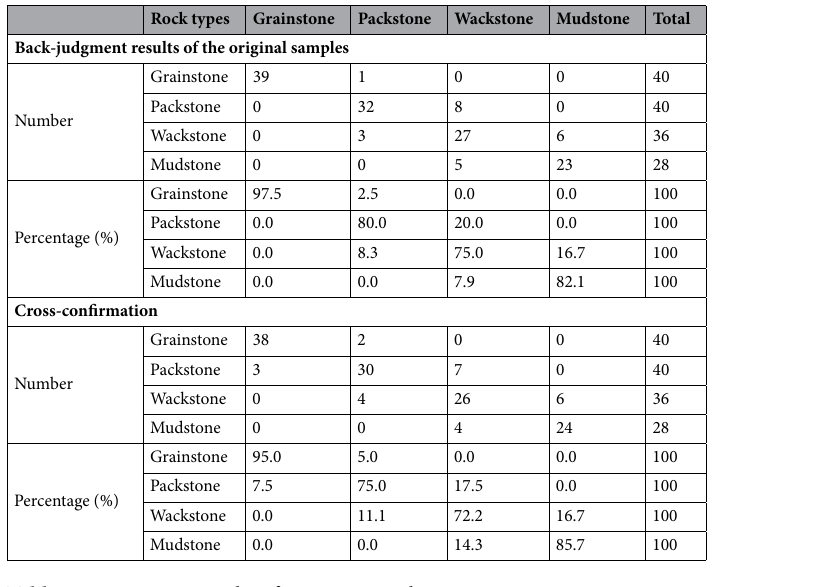
Table 2. Examining results of training